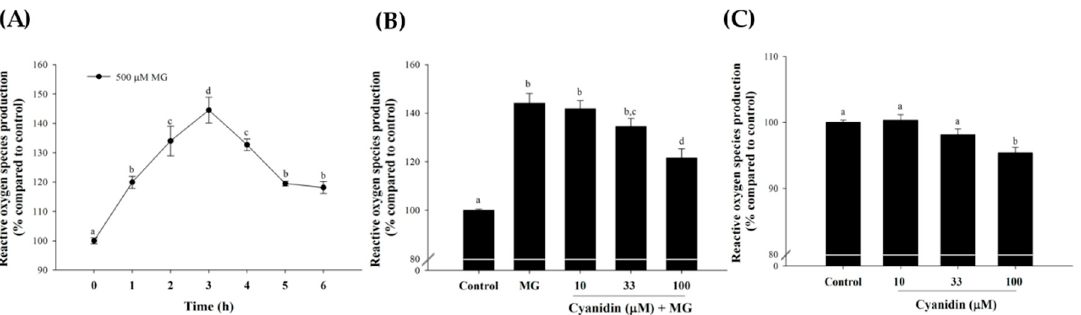
Figure 3 . Effect of cotreatment of cyanidin and 500 µM methylglyoxal (MG) for 3 h on the formation of reactive oxygen species (ROS). ( A ) Treatment of cells with MG increased ROS during a 6 h period, with a peak increase at 3 h. ( B ) Exposure of cells to cyanidin (100 µM) decreased reactive oxygen species (ROS) at 3 h of MG incubation. ( C ) Cyanidin (100 µM) alone altered reactive oxygen species (ROS) levels at 3 h of incubation. Results are presented as mean ± SEM ( n = 3). The groups that do not share a common letter are significantly different ( p < 0.05).